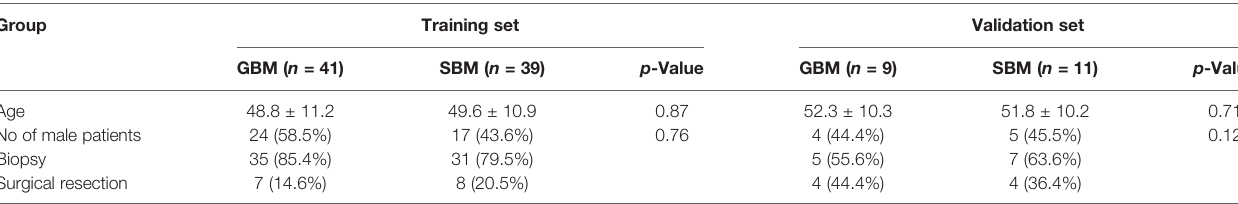
Data are expressed as the mean ± standard deviation. Numbers in parentheses are